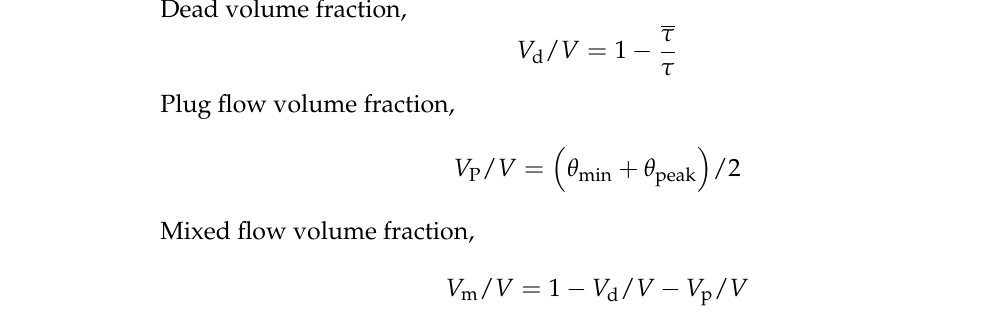
Plug flow volume